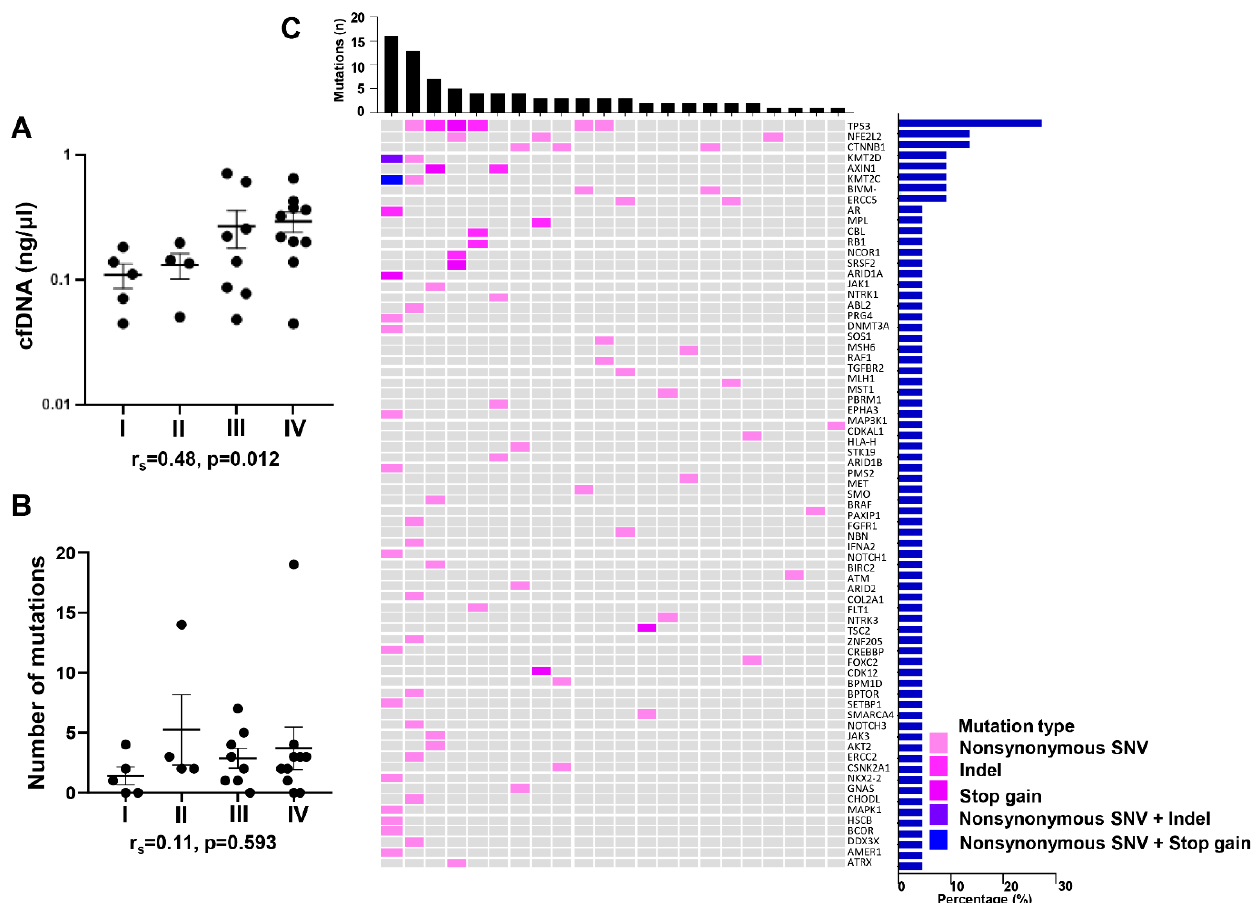
Figure 1. Mutations identified in cfDNA from Hispanic patients with HCC. ( A ) cfDNA concentration in Hispanic HCC patients with different tumor stages. ( B ) Number of mutations detected in cfDNA from Hispanic HCC patients at different tumor stages. ( C ) Genomic landscape of cfDNA from Hispanic subjects with HCC. The heatmap illustrates the nonsynon- ymous mutations detected in plasma cfDNA. The upper bars represent the number of mutations in each patient. The right bars show the frequencies of the altered genes in HCC subjects with detectable mutations. Data are presented as mean ± SEM. r s : spearman correlation coefficient. I: HCC stage 1 ( n = 5); II: HCC stage 2 ( n = 4); III: HCC stage 3 ( n = 8); IV: HCC stage 4 ( n = 10).